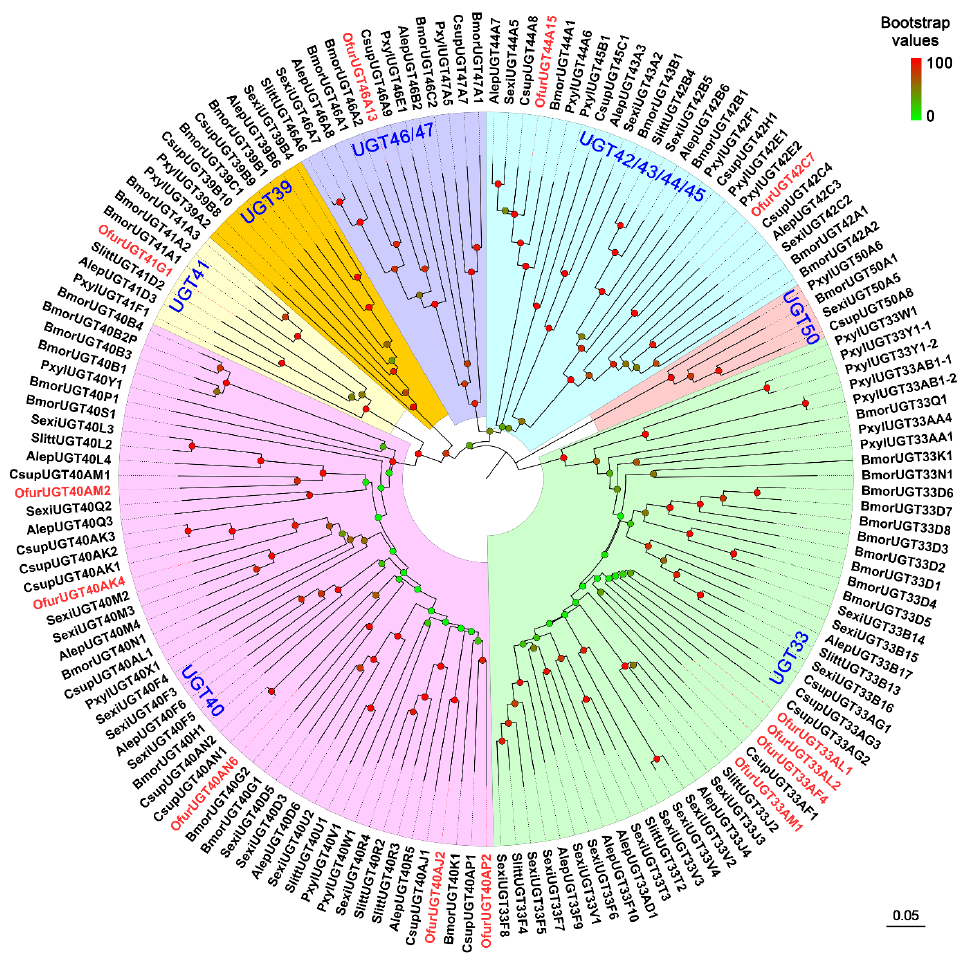
Figure 5. Phylogenetic analysis of UGTs from Ostrinia furnacalis (Ofur-prefix), Bombyx mori (Bmor), Spodoptera littoralis (Slitt), Spodoptera exigua (Sexi), Plutella xylostella (Pxyl), Athetis lepigone (Alep), and Chilo suppressalis (Csup). Bootstrap values are indicated by coloring from green (0) to red (100) on each node. The O. furnacalis UGTs are colored red. UGT sequences used in this analysis are listed in Table S1.